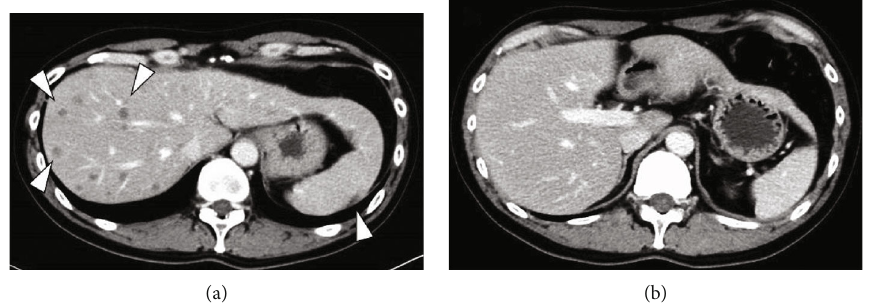
Figure 3: Liver metastases before and after the combination chemotherapy of cisplatin and etoposide: (a) computed tomography showed multiple liver metastases (arrows); (b) liver metastases had achieved complete response in a patient who received combination chemotherapy of cisplatin and etoposide.